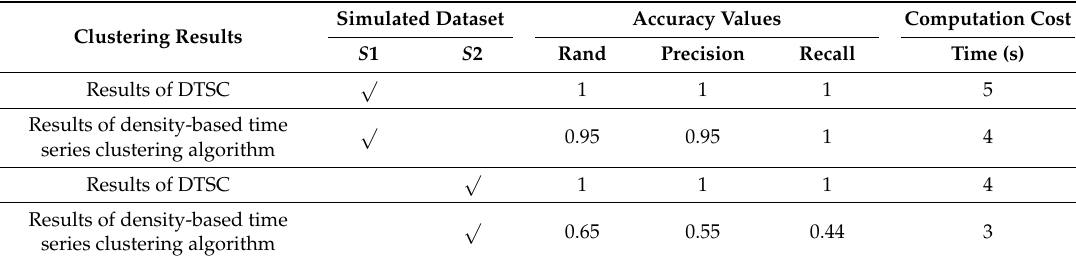
Table 1. Accuracy values of clustering results on simulated datasets and its corresponding computation cost time.